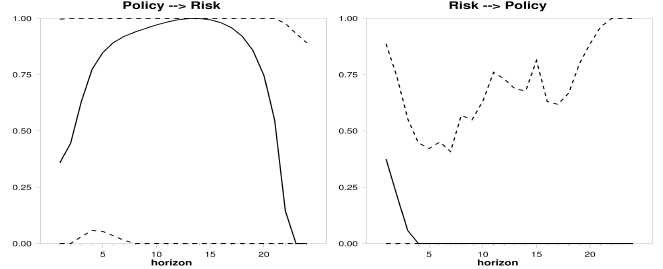
Figure 7. Dashed lines represent the 90% confidence intervals; the values of our measures are between 0 (not significant) and 1. z = COE